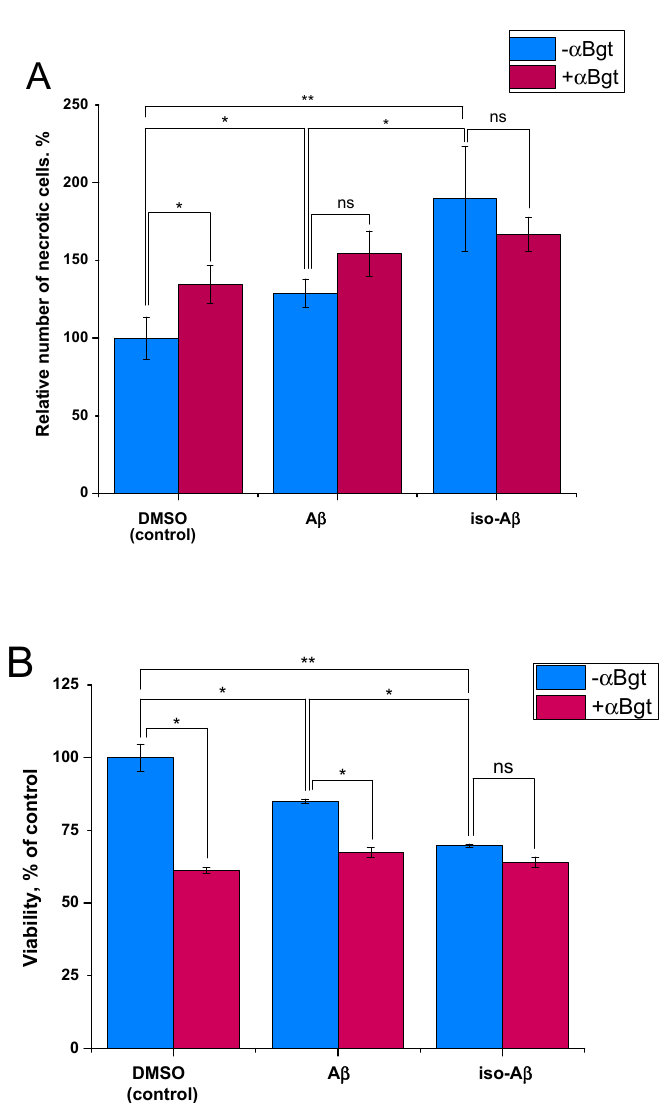
Figure 3. Neurotoxic e ff ects of A β 42 and iso-A β 42 on di ff erentiated SH-SY5Y cells were measured after 72 h of incubation with 10 µ M of peptides in the presence or absence of α -bungarotoxin ( α Bgt) (50 nM). ( A ) Relative number of necrotic cells—represented by normalized Ethidium dimer (EthD-1) fluorescence. ( B ) Viability of cells in relation to the control—measured with the WST test. Data are presented as the mean ± SD of two independent experiments with at least five replicates for each point. * p < 0.05, ** p < 0.01, ns = non-significant. 3.5. Molecular Modeling of the Binding Sites for Iso-A β 42 and A β 42 in the α 7nAChR